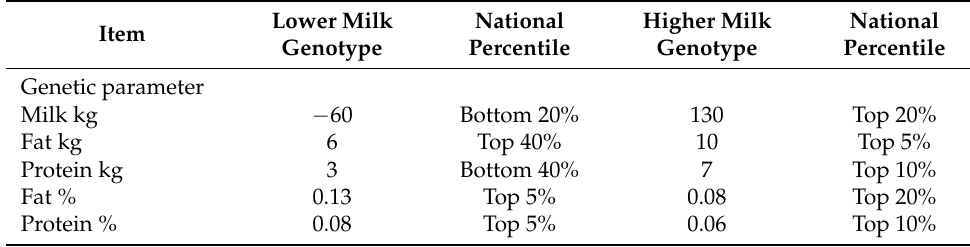
Table 1. Genotype profile of cows in the experiment 1 .